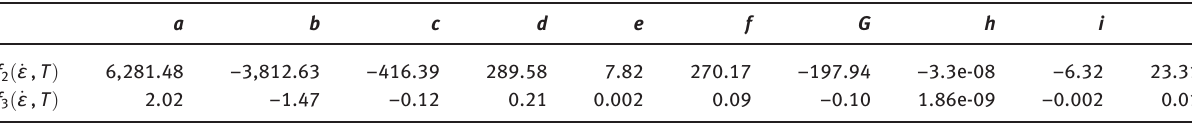
Table 7: Fit results of f 2 ð _ ε , T Þ and f 3 ð _ ε , T Þ of BR1500HS steel at middle temperature ranges. a b